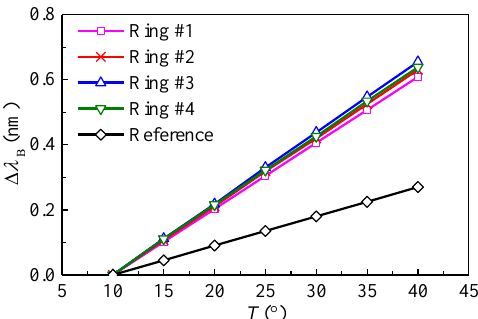
Figure 8. Variation of wavelength shifts of FBGs with temperature.